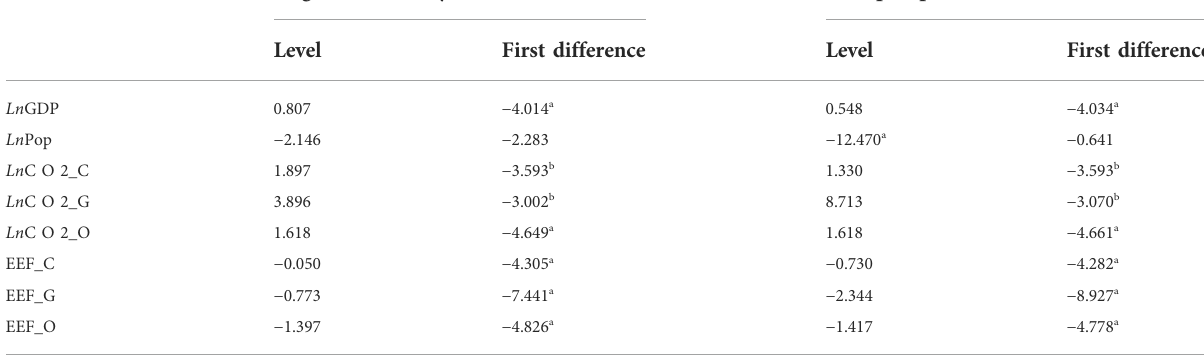
TABLE 1 Result for the unit root test.